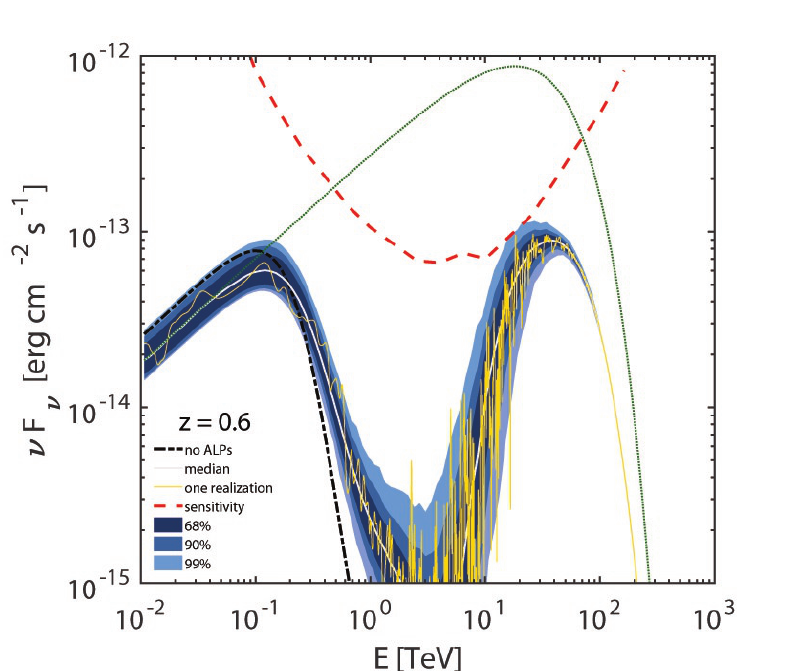
Figure 28. Same as Figure 25 but for a BL Lac at z = 0.6 in the case of observation of the BL Lac along the direction of the galactic plane. (Credit